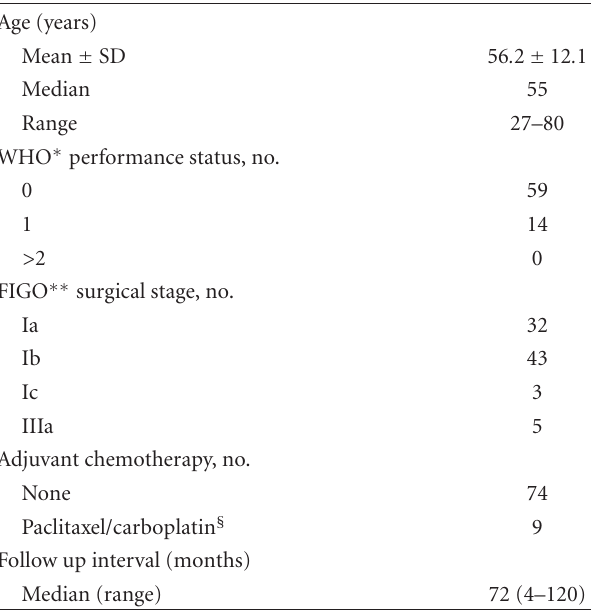
WHO ∗ : World Health Organization, FIGO ∗∗ : International Federation of Gynecology and Obstetrics Paclitaxel/carboplatin § : Paclitaxel (180mg/m 2 ) and carboplatin (area under the curve; AUC 5).